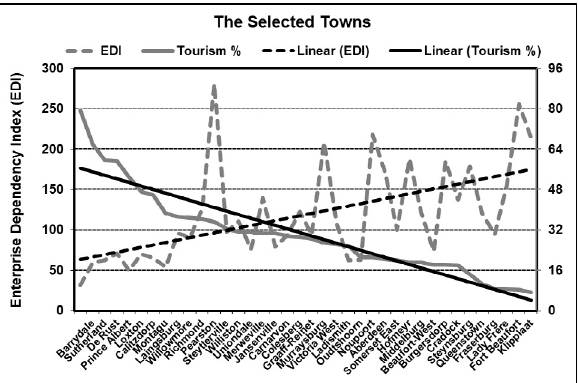
The share of the tourism and hospitality sector as a percentage of the total enterprises (tourism%) of the 38 selected towns in relation to the enterprise dependency indices of the towns. Trend lines were fitted for both